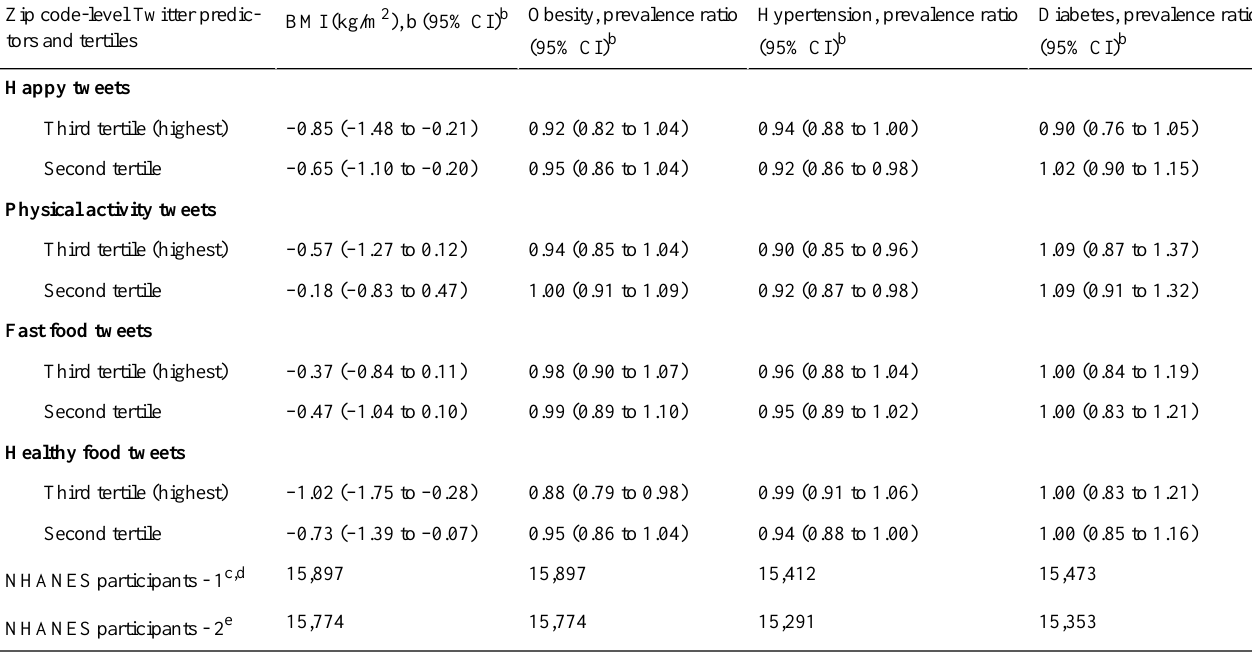
Table 4. Twitter-derived neighborhood characteristics and adult health outcomes in the NHANES 2011-2016 subcohort a